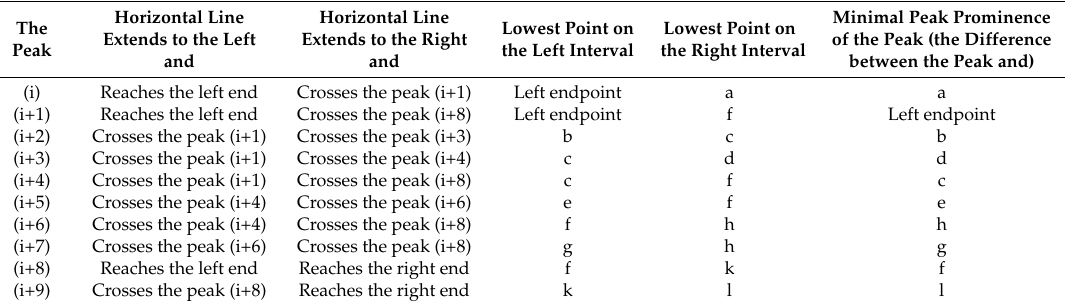
Table 1. The minimal peak prominence analysis.